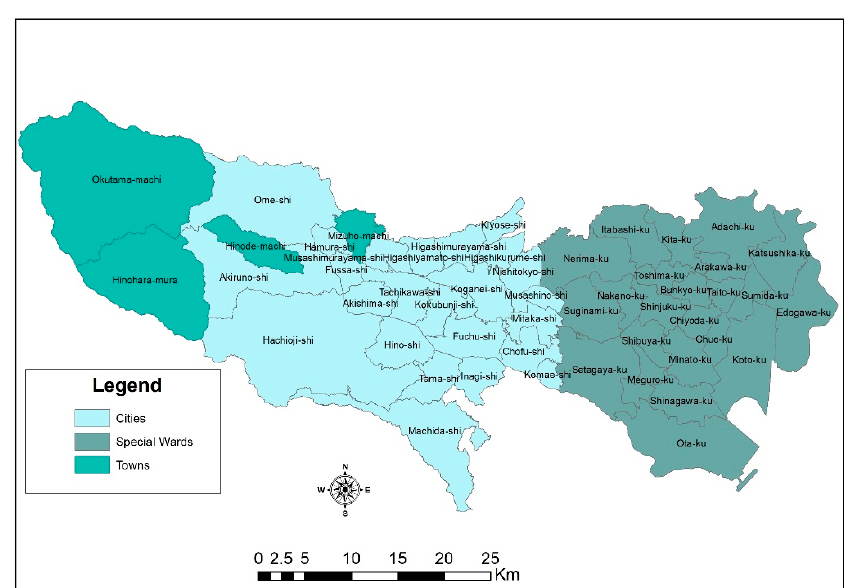
Figure 1. The study area: location of Tokyo metropolitan area.